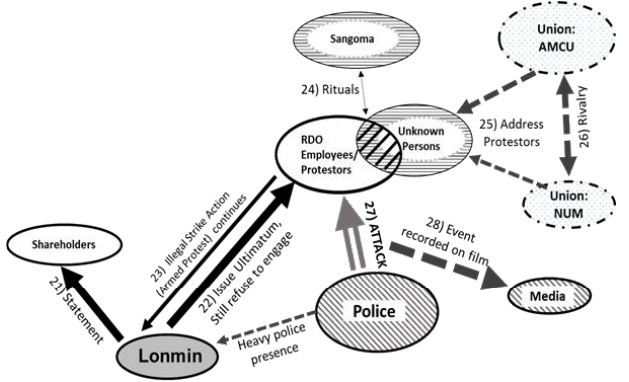
Figure 6: Stakeholder model for Lonmin (Period 16